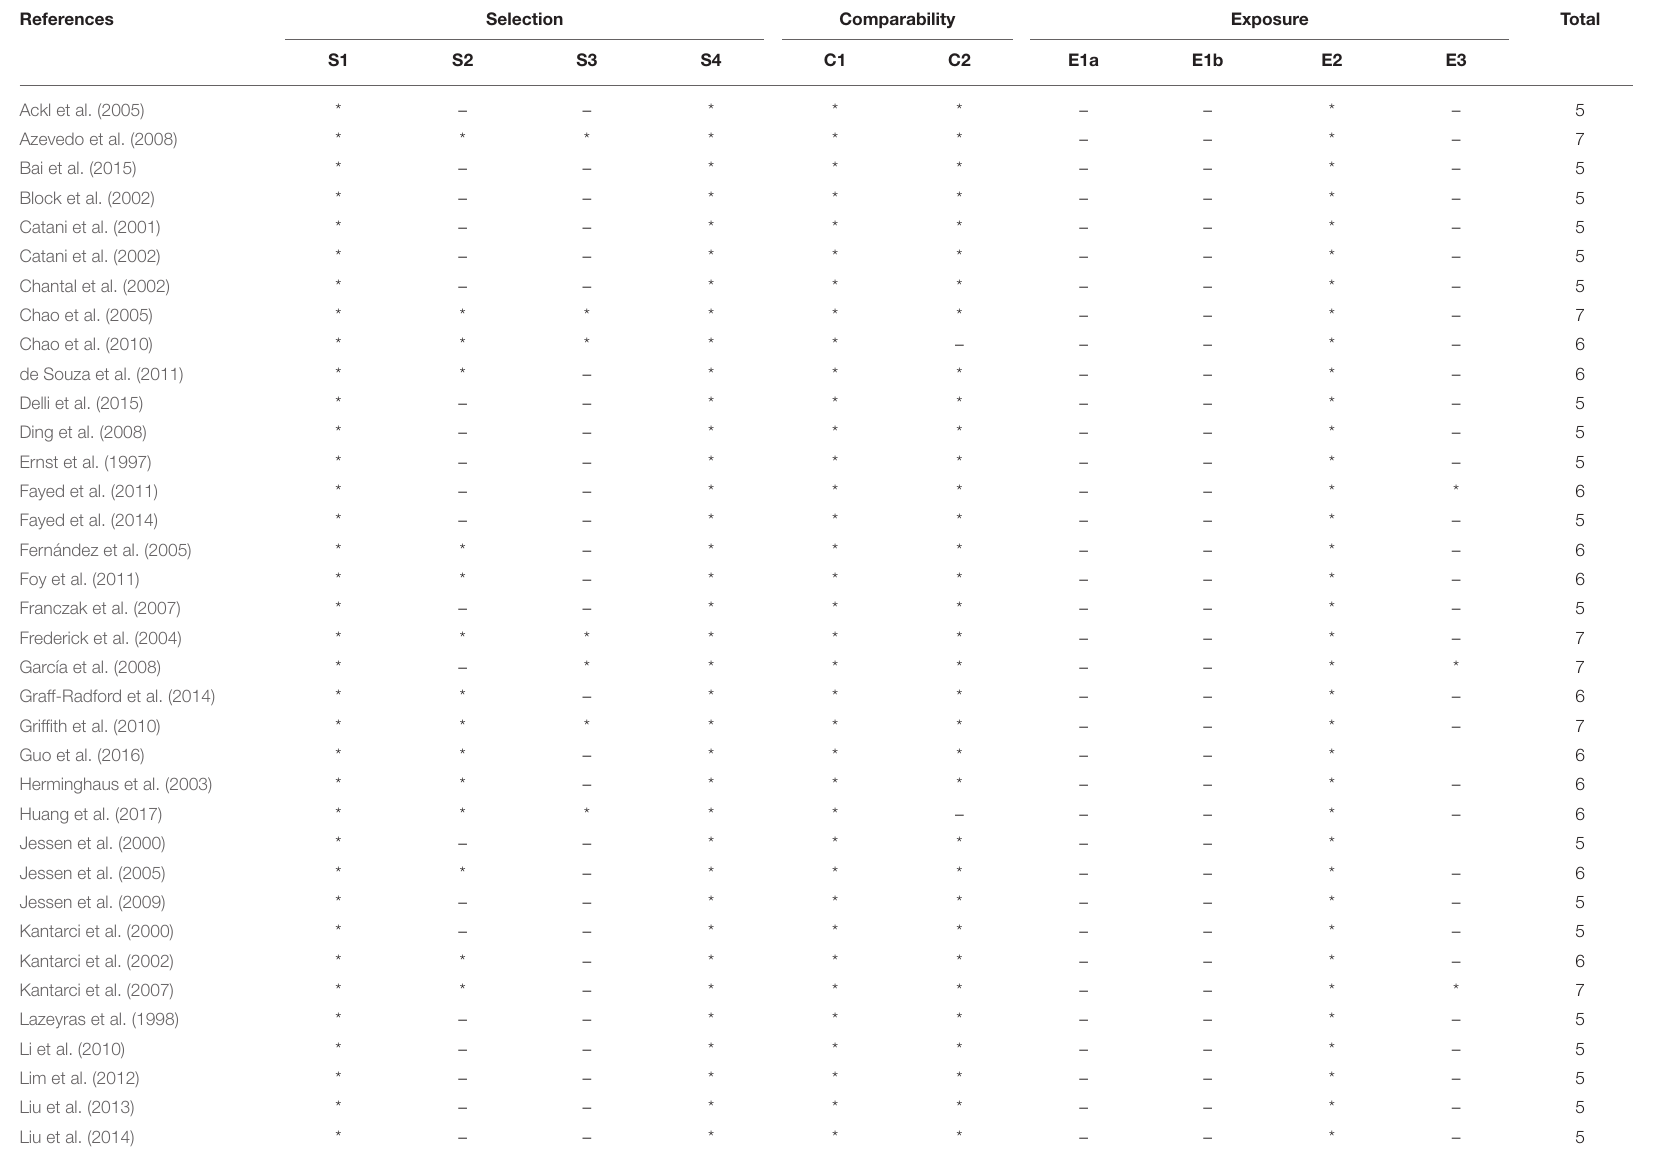
TABLE 2 | The Newcastle-Ottawa Scale (NOS) for the quality assessment of